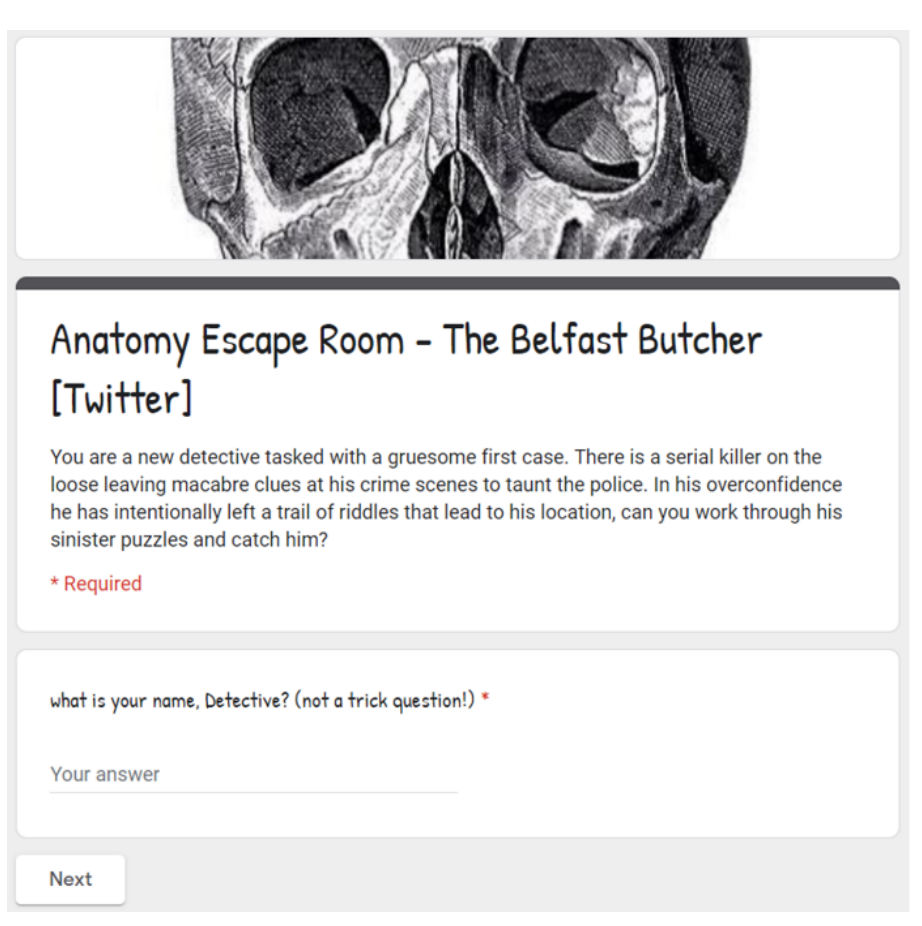
Figure 4. Introductory Page of the Anatomy Escape Room The virtual ER was created in a simple sequential format. Students were presented with a question which they had to solve to proceed to the next question. The game clues were collected along the way in the form of images (Figure 5), links to websites, an embedded video, and Google map locations that aided them in answering the final riddle. The escape room was tested by a group of three lecturers over a video conference prior to release to the students. This was an important step, as it helped to identify technical issues, and misleading questions or clues. To avoid frustration, sufficient clues were made available, along with links to specific reading material containing the answer. These were included to encourage exploration of the learning materials if groups become stuck on a